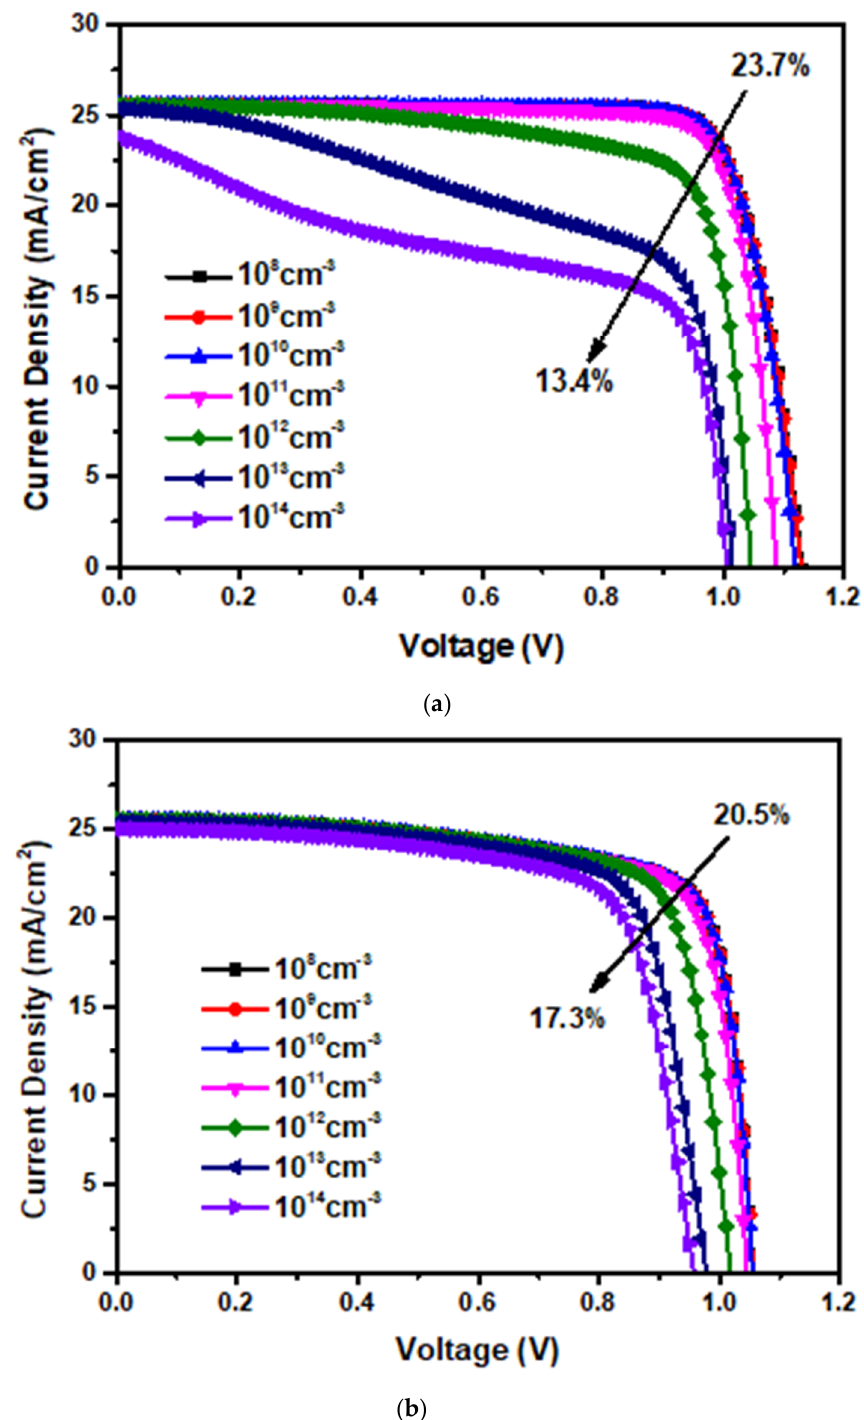
Figure 11. Current density–voltage ( J– V) curves for varying interface defect densities at ( a ) ZnO/PAL and ( b ) PAL/NiO x interfaces.